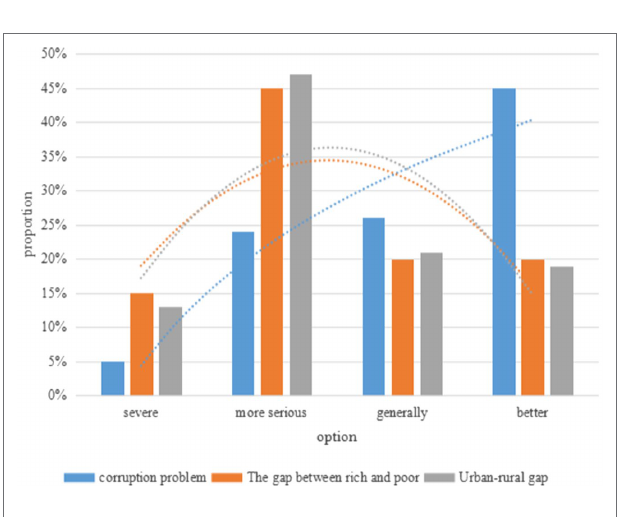
FIGURE 9 | College students’ satisfaction with social justice